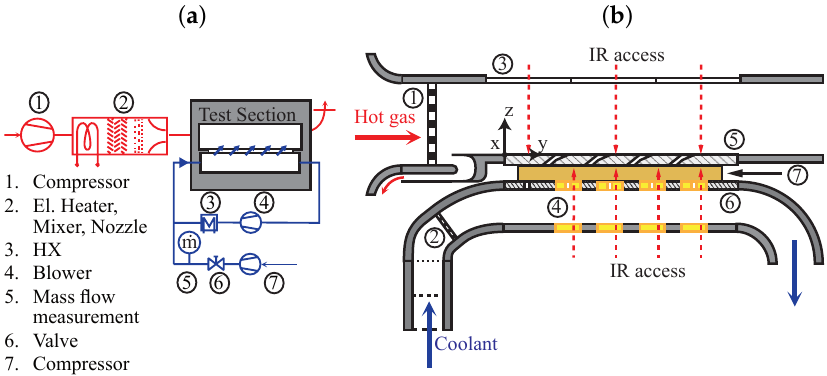
Figure 2. Test facility at ITS showing the hot gas path in red and the coolant path in blue. ( a ) Left Infrastructure, ( b ) right test section with 1 (cid:13) Turbulence grid; 2 (cid:13) Meshes, screens, and turbulence grid; 3 (cid:13) Sapphire windows; 4 (cid:13) Zinc-Selenide windows; 5 (cid:13) Specimen with effusion cooling